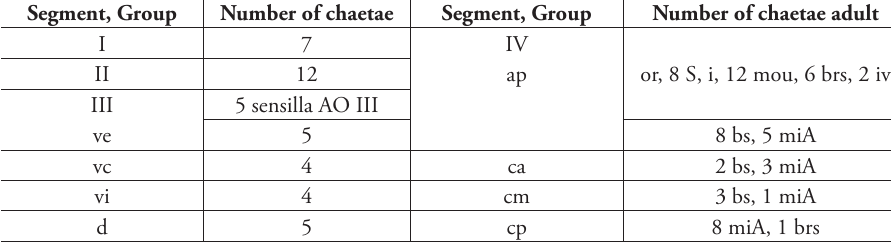
Table 3b. Chaetotaxy of Endonura turkmenica sp. n.: chaetotaxy of